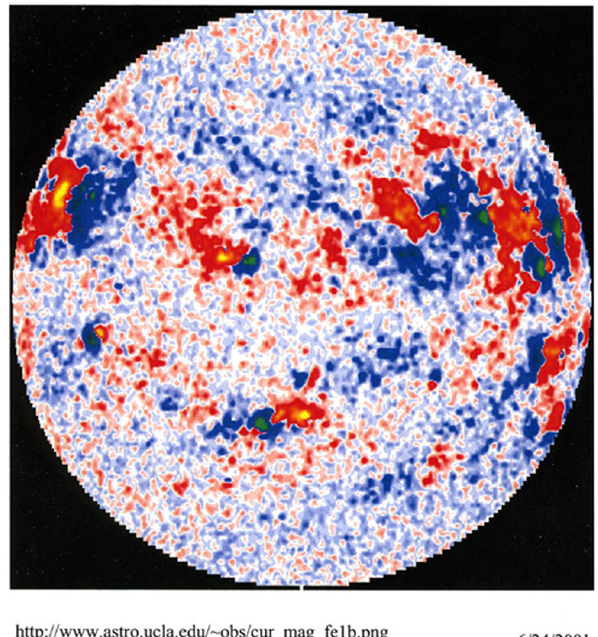
Fig. 3. An example of a solar magnetic observation. Yellow spots are positive sunspots located in positive UM-regions, and green spots are negative spots located in negative UM-regions (courtesy of the Kitt Peak Solar